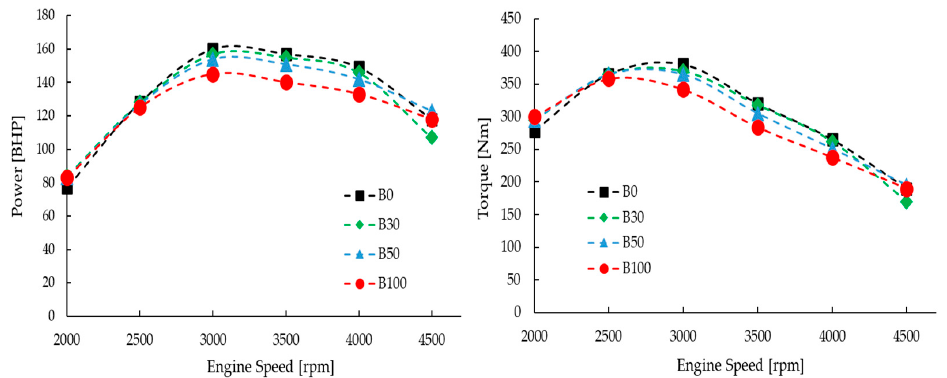
Figure 6. Power and torque of diesel fuel, B30, B50 and B100.